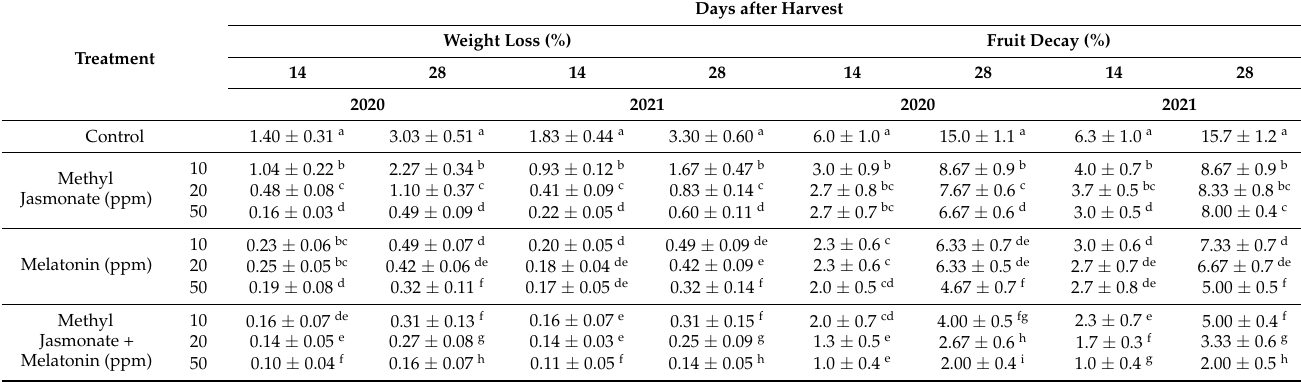
Table 3. Effects of foliar application of melatonin and/or methyl jasmonate solutions at different concentrations on the weight loss (%) and the fruit decay (%) in date palm fruits (cv. Barhi) stored at 4 ◦ C for 28 days